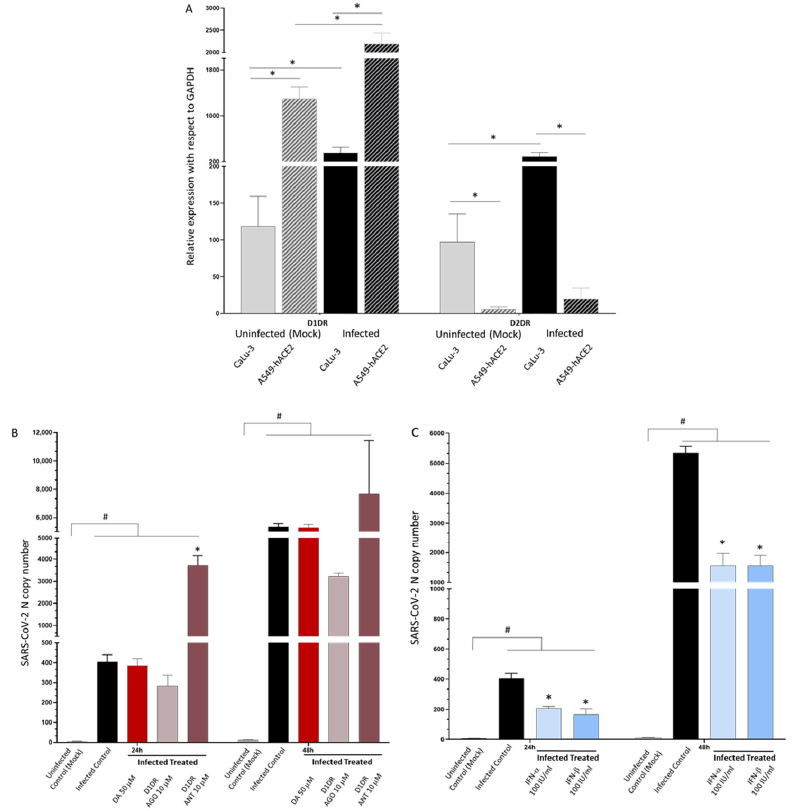
Figure 9. The lack of D2DR expression in A549-hACE2 cells is associated with refractoriness to DA administration and low susceptibility to both SARS-CoV-2 infection and Type-I IFN treatment. ( A ) Relative expressions of D1DR and D2DR in A549-hACE2 compared with Calu-3 cells in either Mock-infected and SARS-CoV-2 infected cells at 48h post-infection. At baseline (Uninfected, Mock), D1DR expression is higher in A549-hACE2 cells while D2DR is almost undetectable compared with CaLu-3 cells. SARS-CoV-2 (Infected Control) increases D1DR expression by 2-fold and 1.5-fold compared with Uninfected Control in CaLu-3, and A549-hACE2 cells, respectively, while a 2-fold increase in D2DR expression is observed only in CaLu-3 cells. In fact, even following SARS-CoV-2 infection, D2DR expression remains almost undetectable in A549-ACE2 cells. mRNA quantification